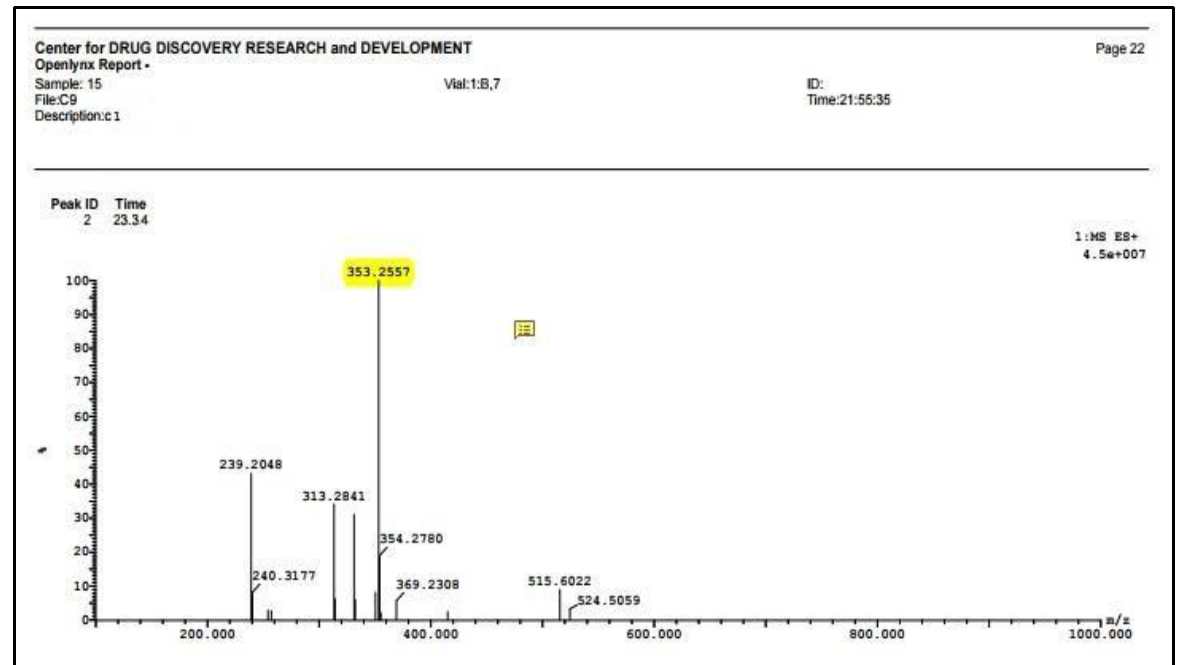
Figure 5. UPLC chromatogram of isolated aq1 compound. Mass 1 of isolated compounds.